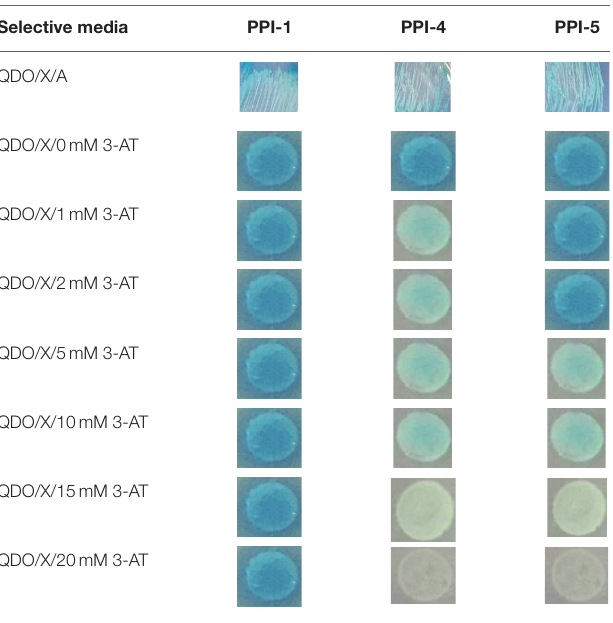
TABLE 1 | Determination of PPI strength using biochemical